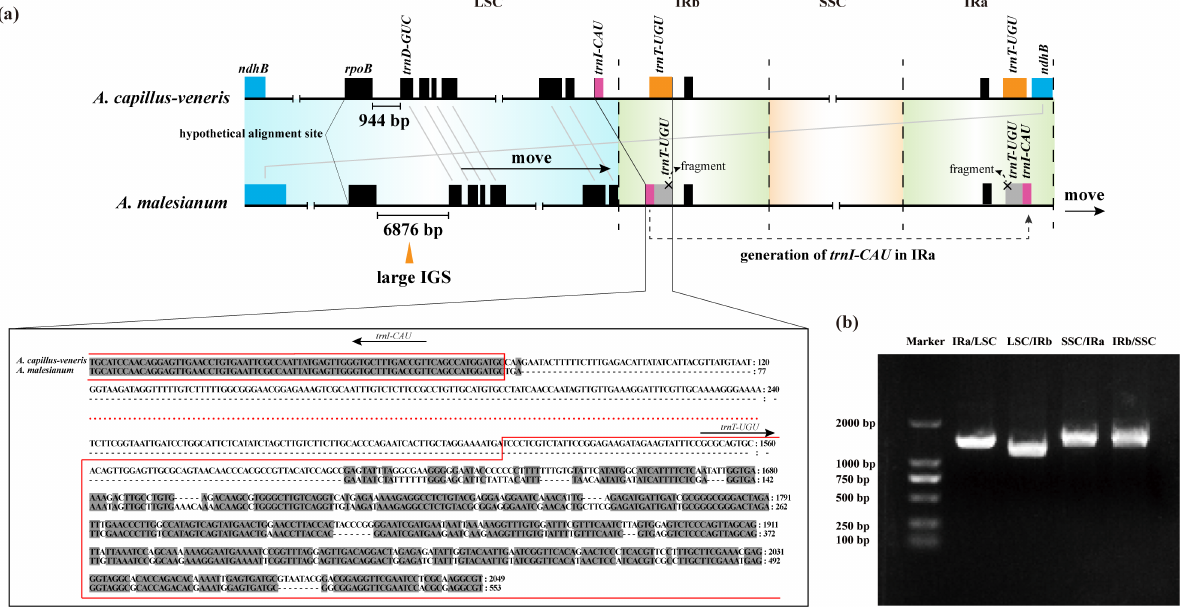
Figure 4. ( a ) A model to explain the structural change around IR/SC boundaries in the A. malesianum cp genome. It shows that the large rpoB-trnD-GUC IGS causes sequential gene movement in LSC, leading to trnI-CAU being “squeezed” into IRb and replacing part of trnT-UGU ; then, the generation of trnI-CAU in IRa leads to the movement of ndhB from IRa into LSC. Adiantum capillus-veneris is used as the reference, because it has the highest level of homology with A. malesianum . Gene ropB is set as the start site of alignment. Black horizontal lines represent gene sequences; “||” represents sequence omission. Black boxes indicate identical genes; colored boxes are genes with location changes at the IR/SC boundaries. Of them, the trnT-UGU gene in A. malesianum is experimentally confirmed as unable to be normally expressed, as it only has a partial fragment remaining. Inset is the sequence alignment of trnT-UGU , trnI-CAU and their intergenic spacer between the two species; gray color indicates an identical site, red dots represent omitted bases present in A. capillus-veneris and “-” represents the gap. The number on the right side of the sequence is the number of bases. ( b ) Electropherogram showing the amplified DNA fragments corresponding to the four IR/SC boundaries in the A. malesianum cp